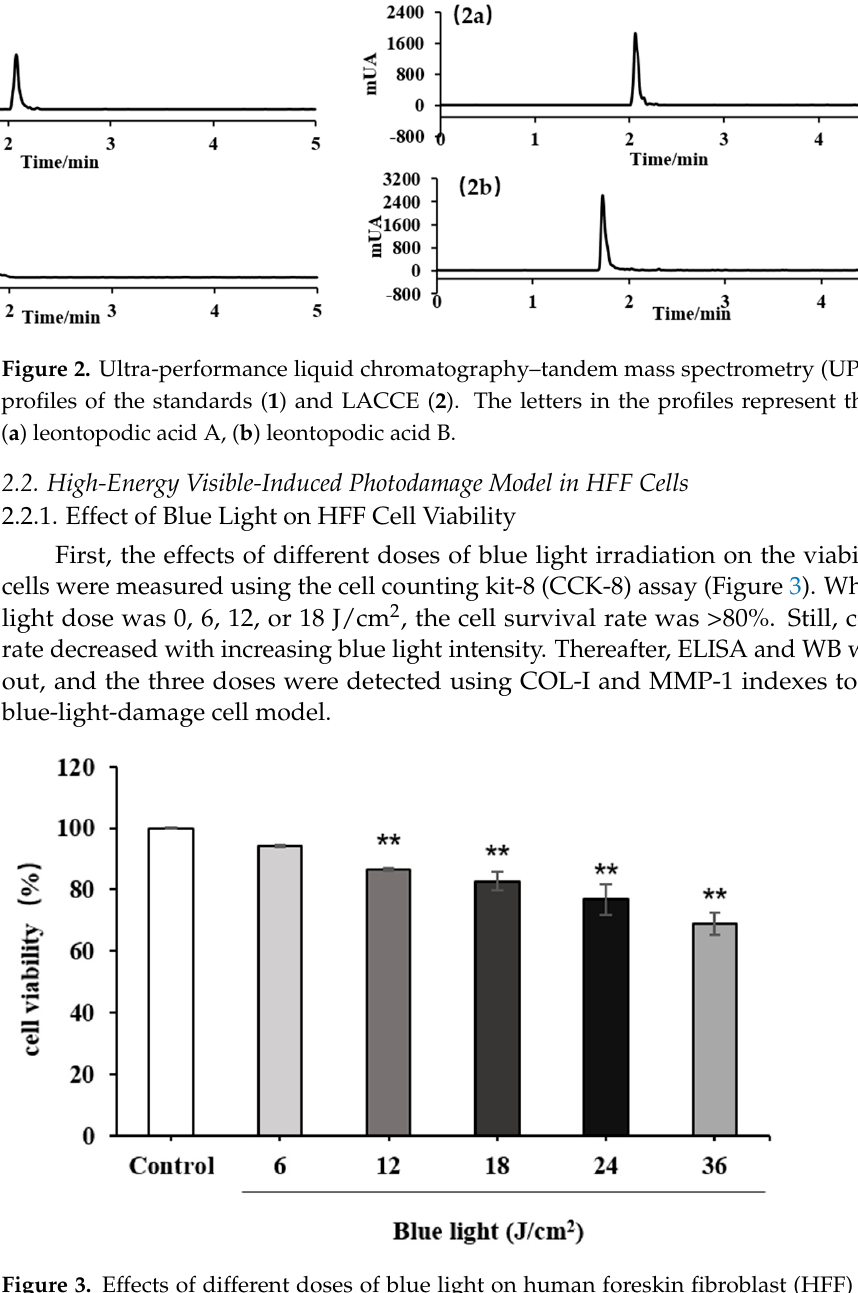
Figure 3. Effects of different doses of blue light on human foreskin fibroblast (HFF) cell viability. The data are expressed as mean ± standard deviation (SD) of three independent experiments ( n = 3). The data were analyzed using one-way analysis of variance (ANOVA) followed by Tukey’s test. ** p < 0.05, versus cells without blue light treatment.